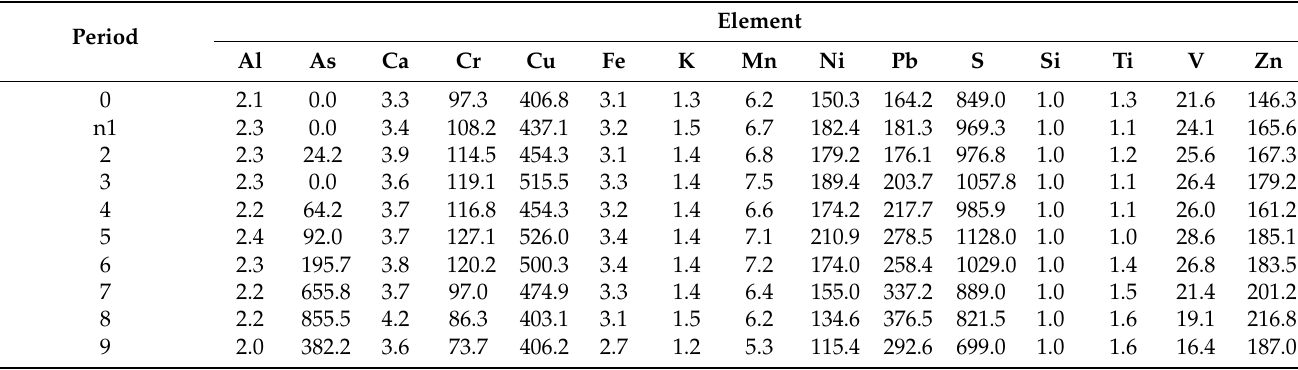
Table 3. The enrichment factors (EFs) for the PM 10 -bound elements, averaged for each hour of the day and the measurement period.